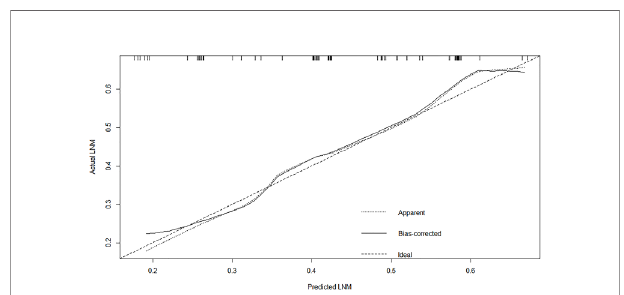
FIGURE 4 | The calibration plot showed a high fi t between actual and predicted lymph node metastases in external set.